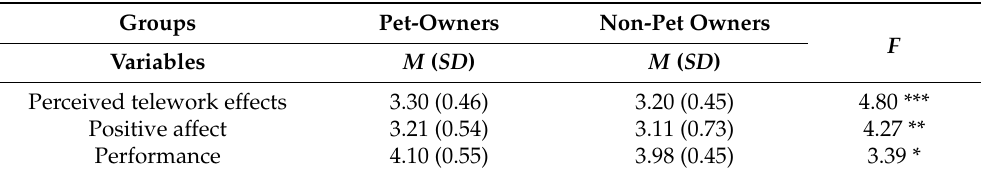
Table 2. Means comparisons between the two groups of participants (pet owners versus non-pet owners).